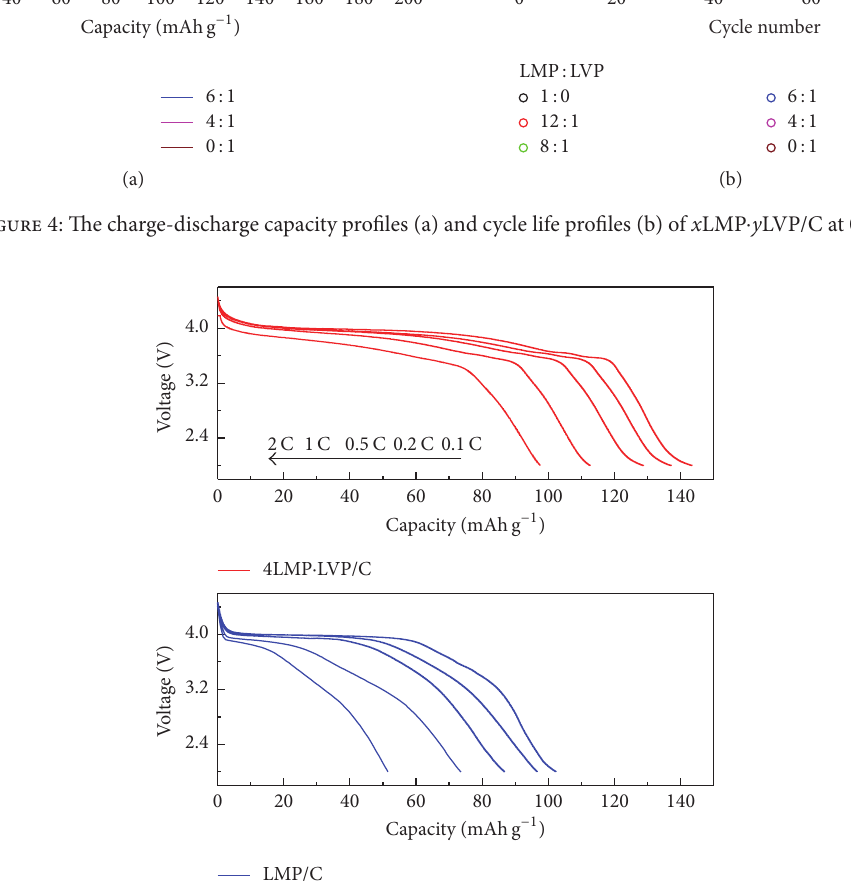
Figure 5: Discharge profiles of LMP/C and 4LMP ⋅ LVP/C at different